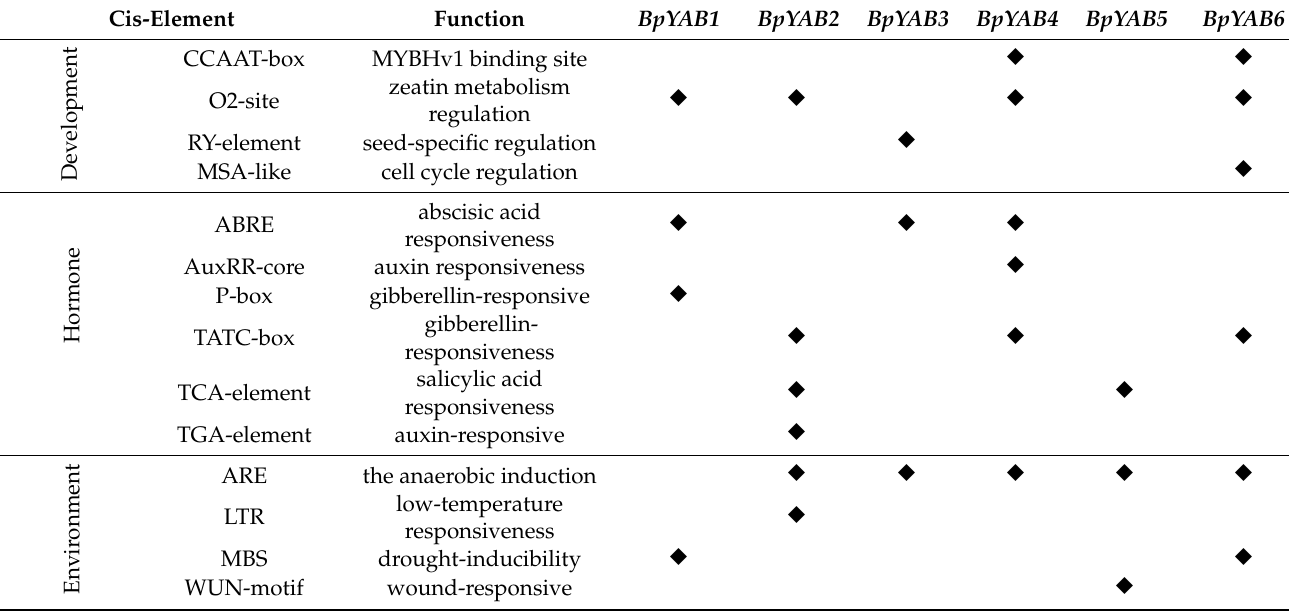
Table 2. Predicted cis -elements in BpYAB promoters.